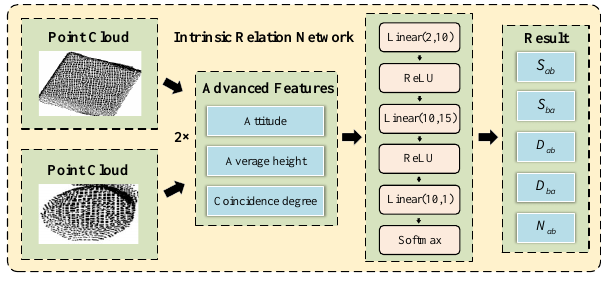
Figure 6. Structure of the Relationship Exploration